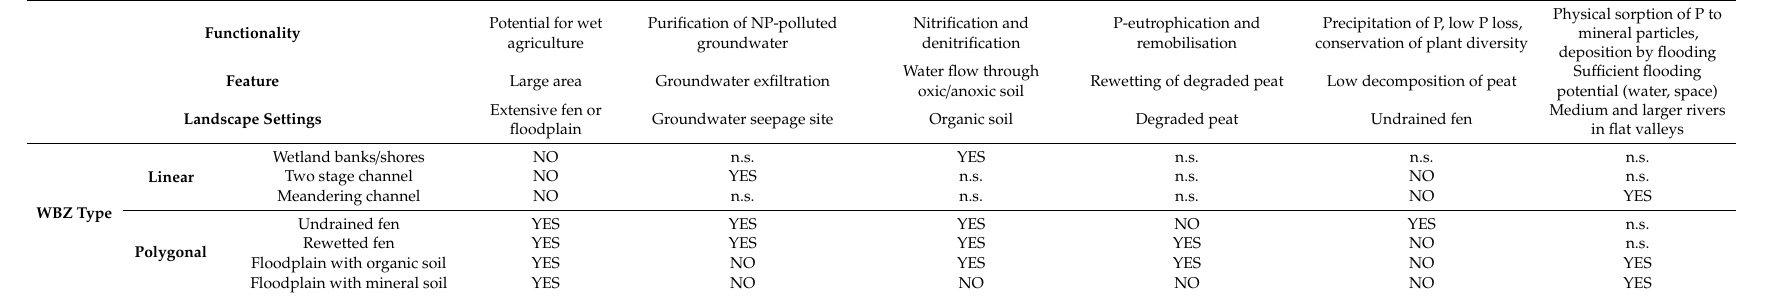
Table 1. WBZ types and their functionalities and landscape settings.